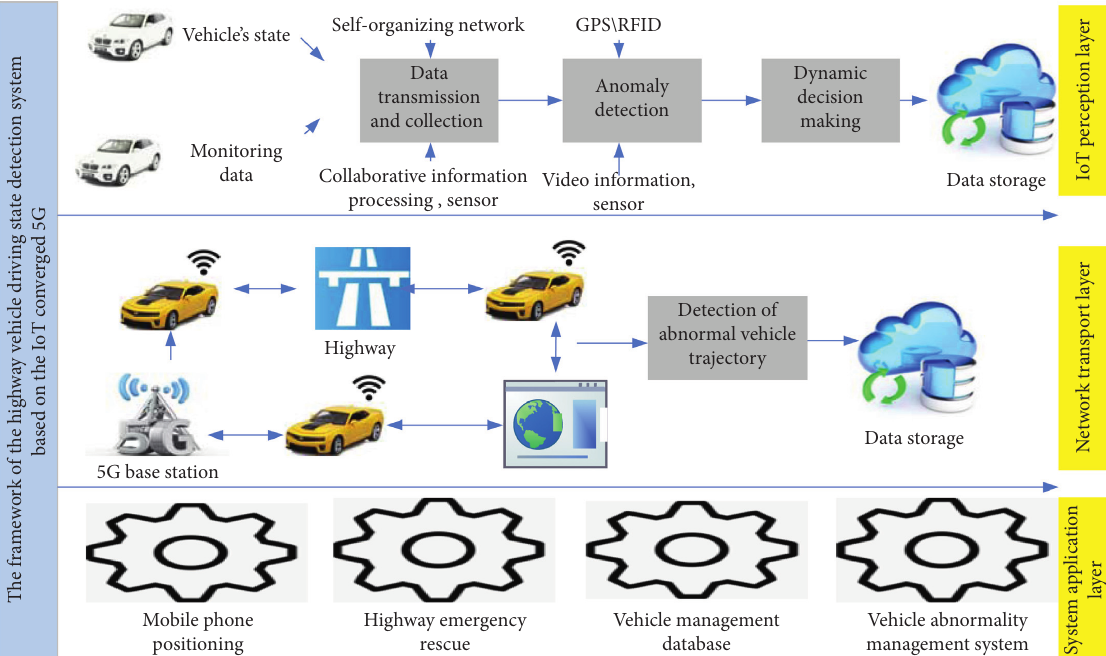
Figure 4: The framework of the highway vehicle driving state detection system based on the integration of the Internet of Things and 5G